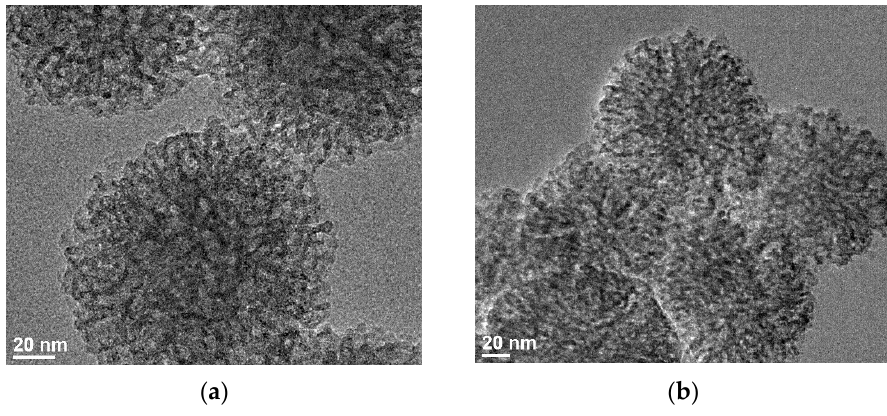
Figure 3. TEM images of ( a ) 5-[Mn III ]@SNP and ( b ) 5-[Mn III ]@CSNP.